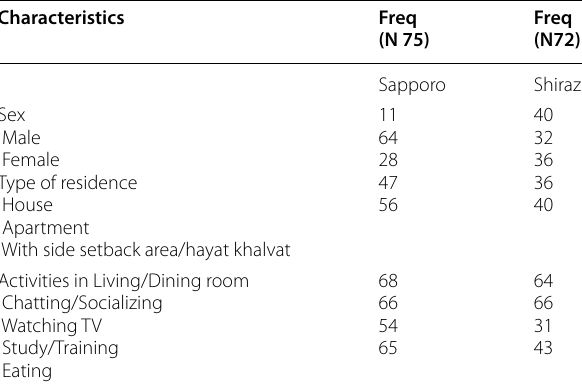
Table 1 Comparative table showing